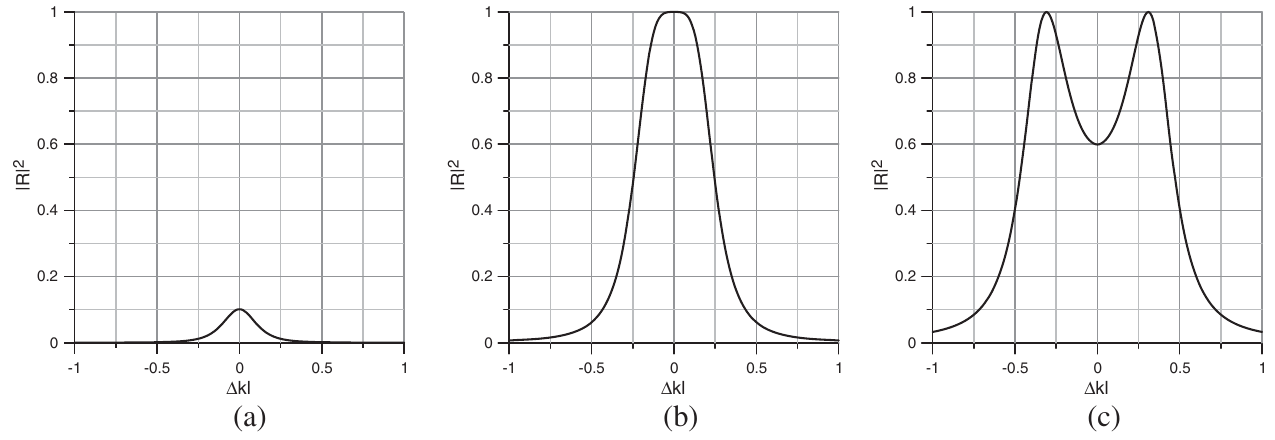
FIG. 6. Spurious reflection caused by mutual coupling of the operating and spurious degenerate eigenmodes: (a) coupling is small; (b) coupling is critical; (c) coupling is too big.